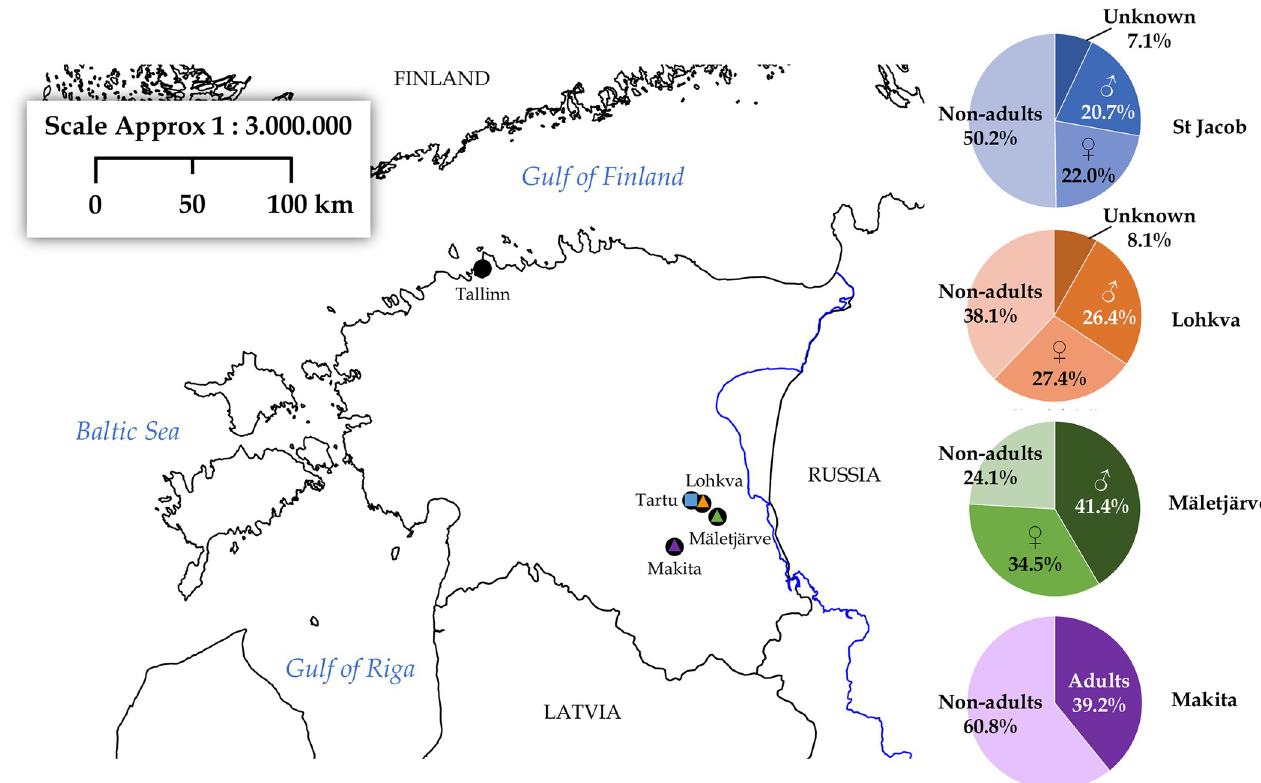
Fig 2. Location of the studied rural and urban cemeteries. Squares indicate urban contexts, while triangles represent rural areas. The demographic analysis for each site is reported in the pie charts, which show a high variability in the percentage of non-adult individuals in each context [54, 57, 59, 60]; (Malve, original data). ♂ = adult males; ♀ = adult females; non-adults = individuals under 17 years of age; Unknown = adult individuals for whom sex estimation was not